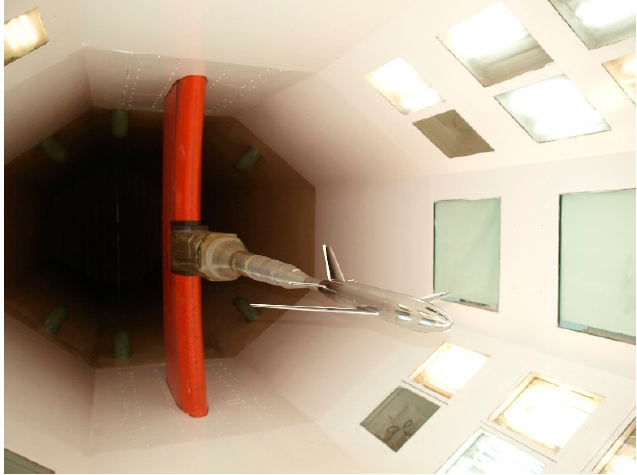
Figure 5. ONERA-M model (M4 size) in the T-35 wind tunnel of VTI.